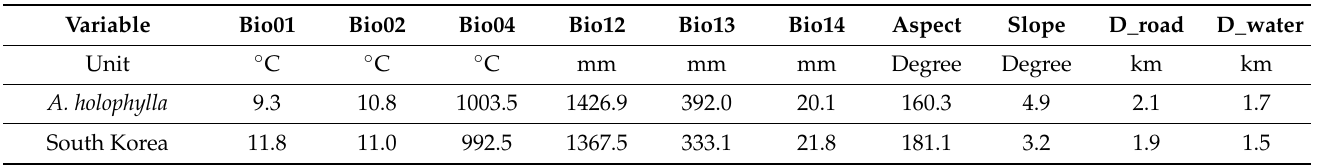
value of the environmental variable itself was